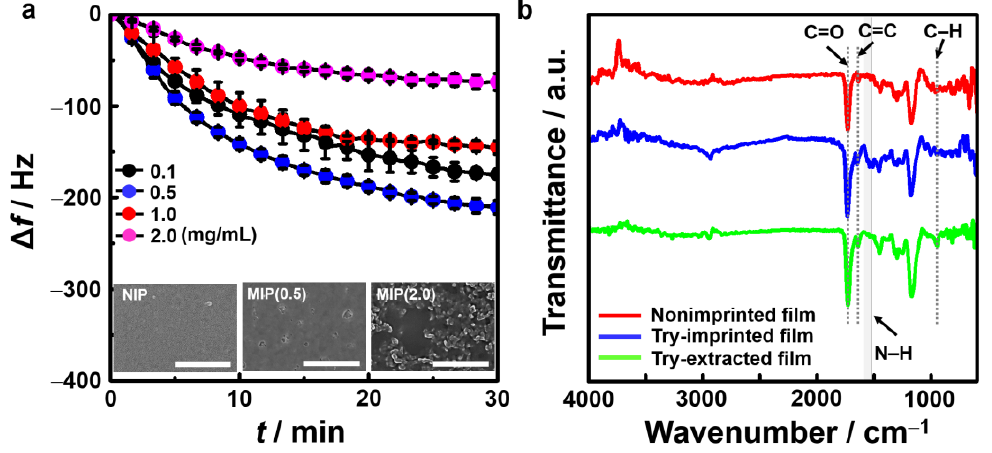
Figure 2. ( a ) Δ f of MIP sensors fabricated by spin-coating solution of different TRY concentrations (0.1–2.0 mg/mL). The measurements were performed in a 75 mL PBS (10 mM, pH = 7.4) solution containing 0.24 µ g/mL TRY for 30 min for adsorption. The insets of Figure 2a show SEM images of NIP film and MIP films (MIP(0.5) and MIP(2.0) made by spin-coating with 0.5 and 2.0 mg/mL TRY solutions, respectively). All scale bars are 1 µ m. ( b ) Fourier-transform infrared spectra of NIP and TRY-imprinted/extracted MIP films.